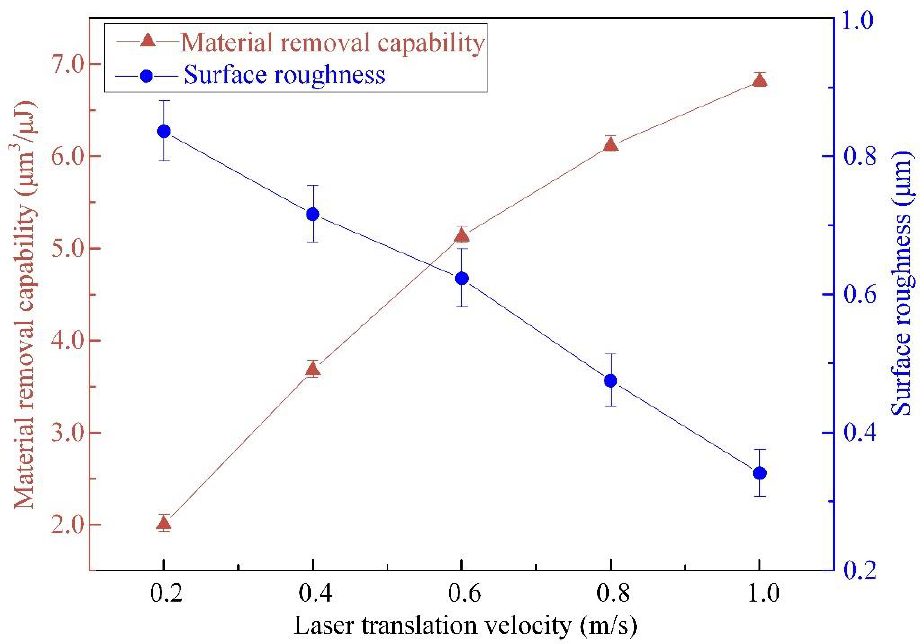
Figure 12. Effect of laser translation velocities on the material removal capability and surface roughness of micropillars, with a pulsed laser beam energy of 50 μJ and a pulsed repetition rate of 600 kHz.